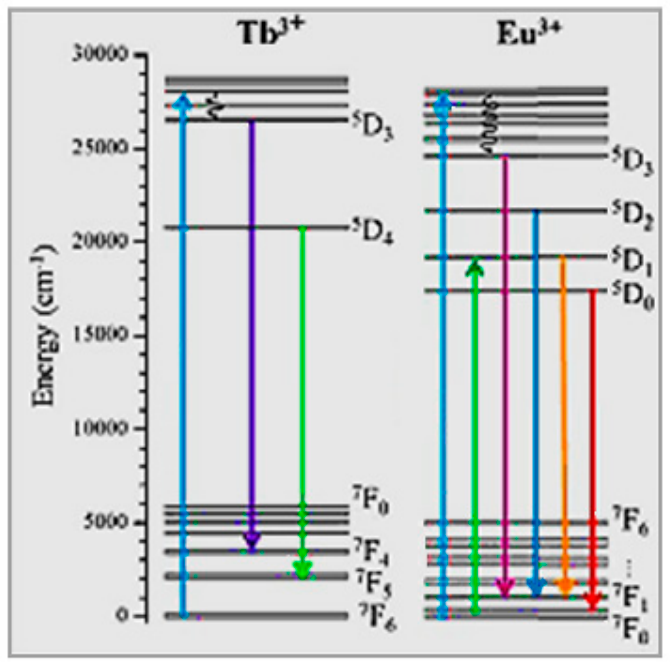
Figure 9. Energy levels of Tb and Eu. In the case of Tb-Eu co-doping, Tb can act as a sensitizer driving multicolor emissions from Eu.